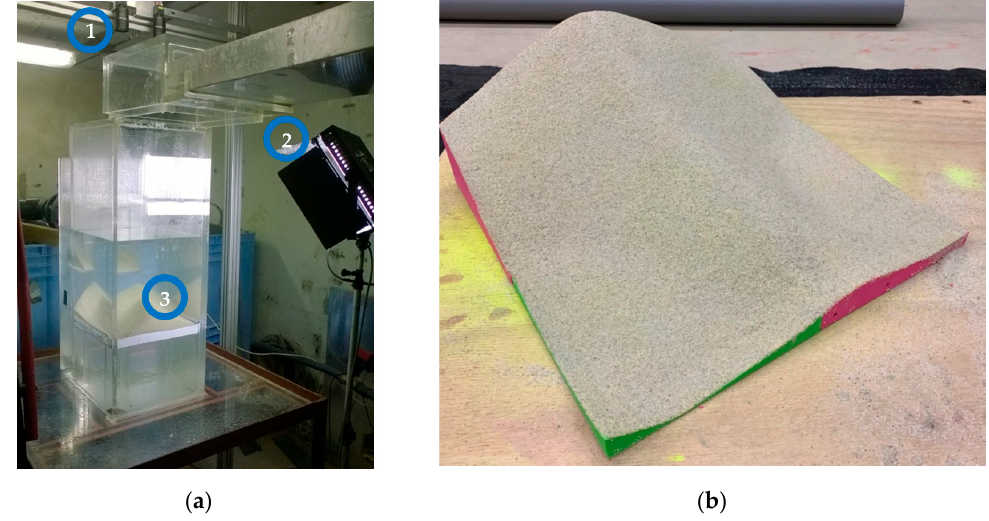
Figure 6. ( a ) The build-up of the sediment bed was carefully stopped, while the water level was kept constant and consecutively stereo photos of the bed were made with the shown setup. 1. Cameras